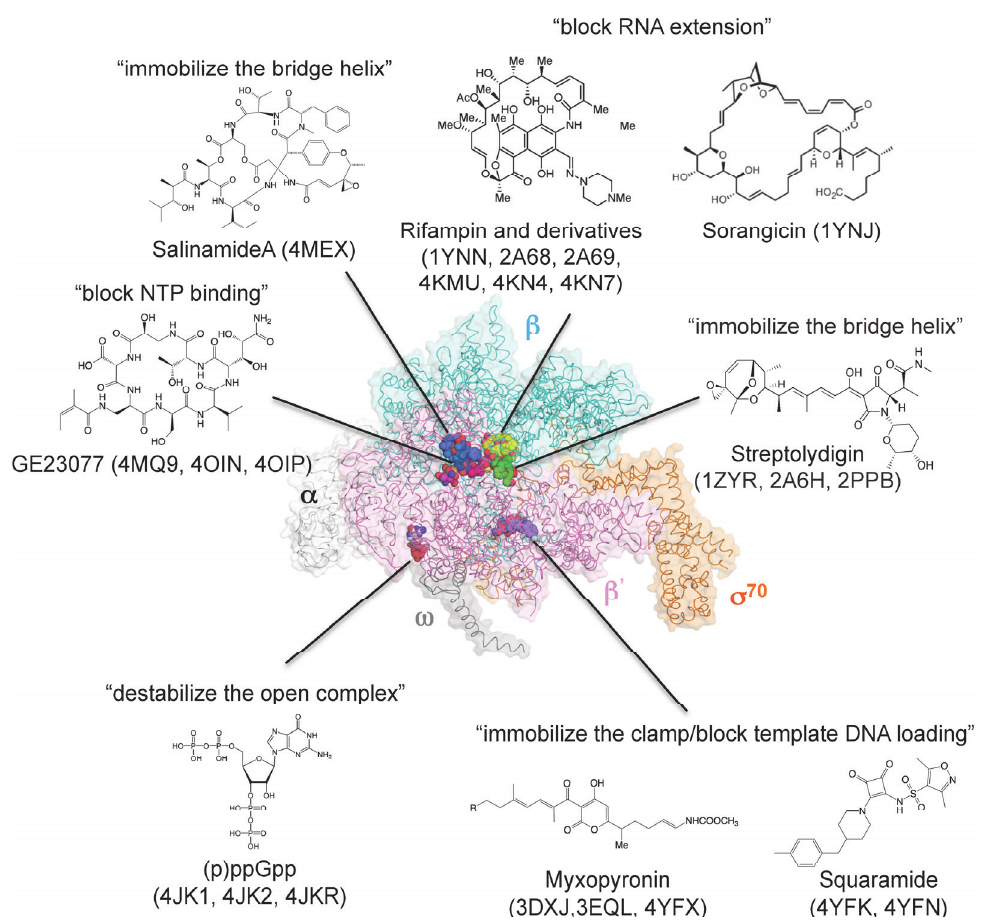
Figure 3. Three-dimensional representation of targets of small-molecule RNAP inhibitors. E. coli RNAP holoenzyme is depicted as an (cid:3)-carbon backbone traced with partially transparent molecular surfaces ((cid:3) subunits: white; (cid:4) subunit: cyan; (cid:4)' subunit: pink; (cid:5) subunit: gray; (cid:2) 70 : orange). Small-molecule inhibitors bound to RNAP are depicted as CPK models. Chemical structures of small-molecule inhibitors and mechanisms of transcription inhibition are